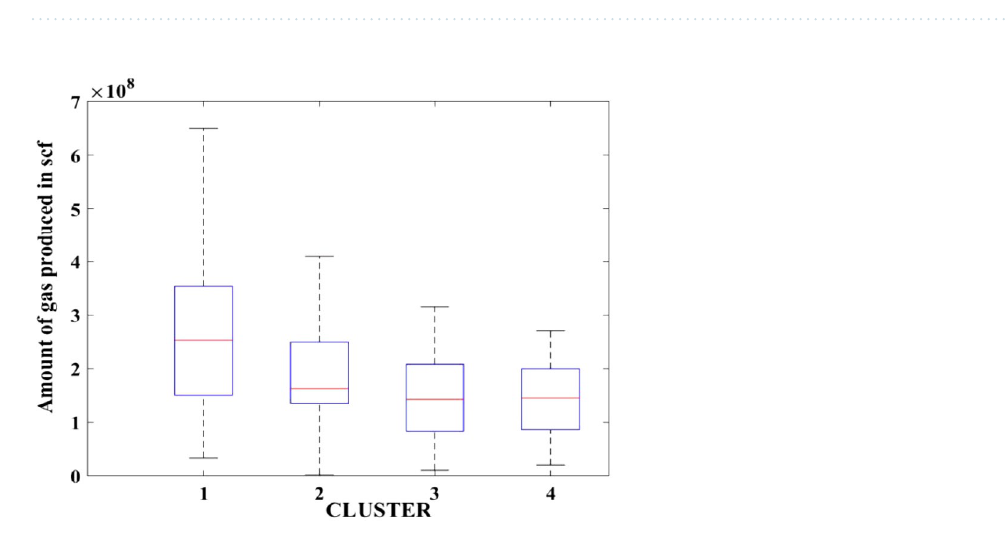
Figure 12. Initial 24-h period oil produced.